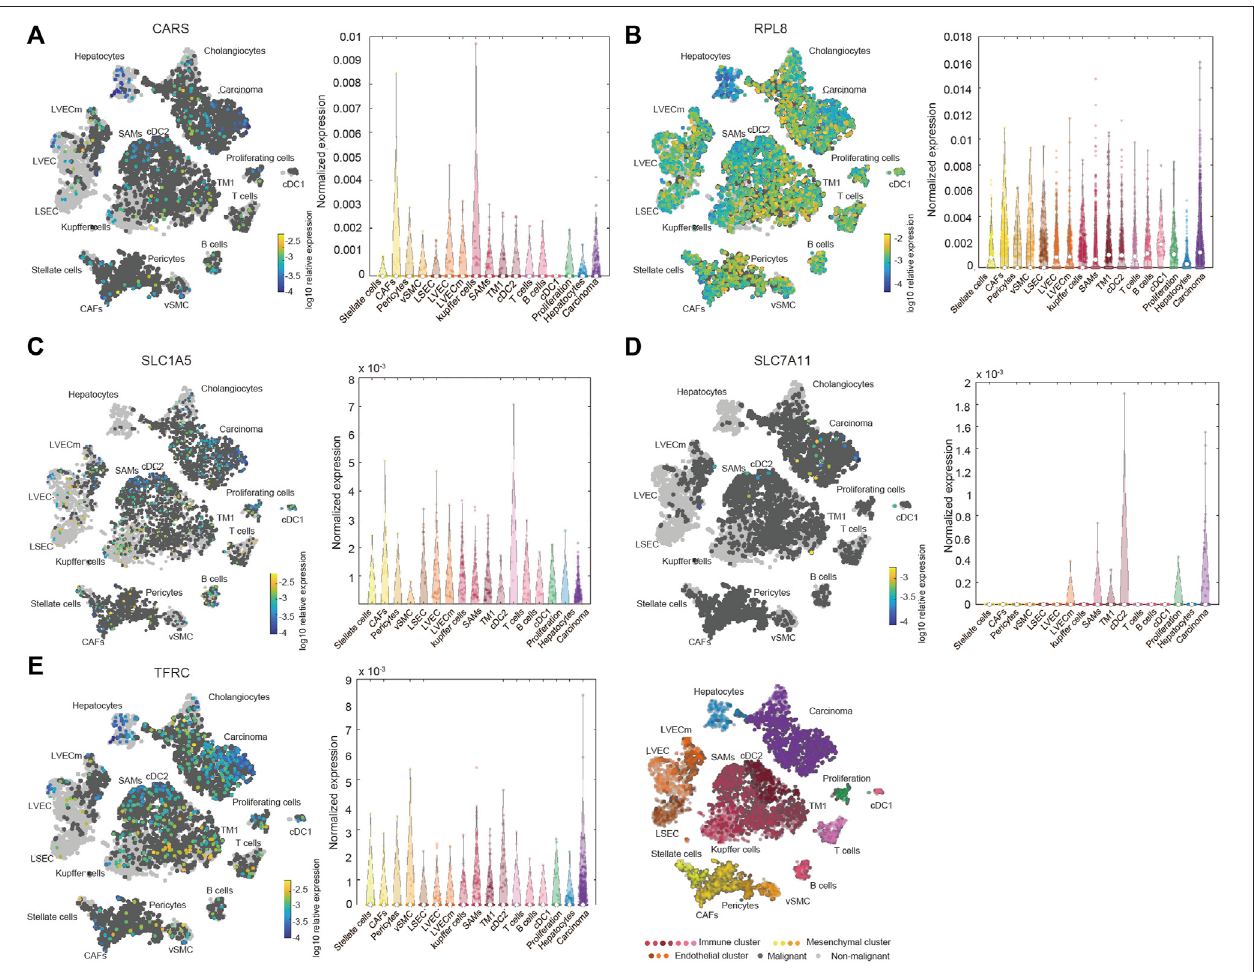
FIGURE 6 | Increased expression and distribution of CARS1 (A) , RPL8 (B) , SLC1A5 (C) , SLC7A11 (D) and TFRC (E) in HCC according to single-cell RNA-seq analysis using the Human Liver Browse database (https://itzkovitzwebapps.weizmann.ac.il/webapps/home/session.html?app=HumanLiverBrowser). The left tSNE plots show the expression of 5 FRGs in 17 Seurat clusters. The identi fi ed clusters are represented by different colors. The light grey dots represent non-malignant cells (normallivercells),thedarkgreydotsrepresentthemalignantcells(HCCcells),andthedifferentcolordotsrepresenttheimmunecluster,mesenchymalclusterand endothelial cluster. The right panel shows the normalized expression of each gene in different